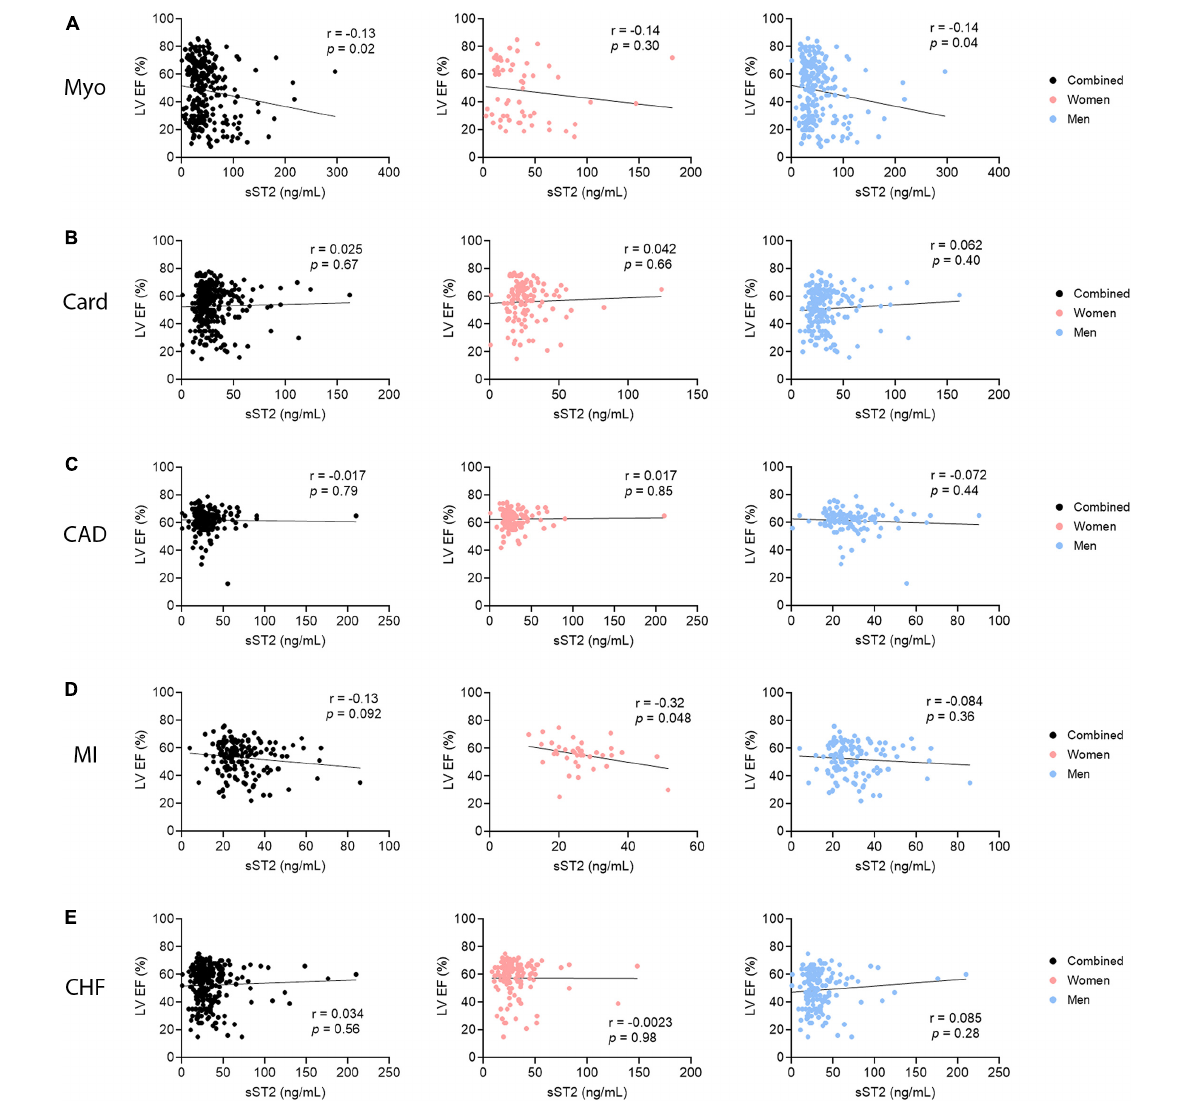
FIGURE8 Soluble ST2 (sST2) relationship to LVEF by sex. sST2 levels in men and women (black), women only (peach), or men only (blue) were correlated to % left ventricular ejection fraction (LVEF) for (A) myocarditis (Myo), (B) cardiomyopathy (Card), (C) coronary artery disease (CAD), (D) myocardial infarction (MI), or (E) congestive heart failure (CHF). P -values were calculated using 2-tailed Pearson